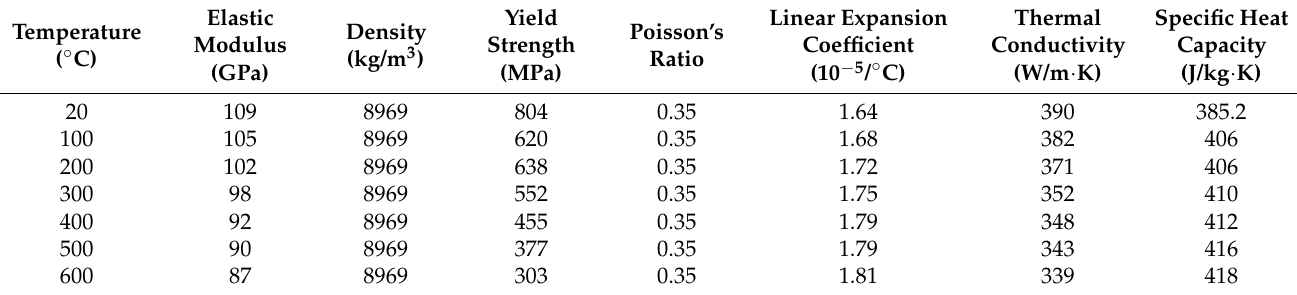
Table 4. Physical property parameters of